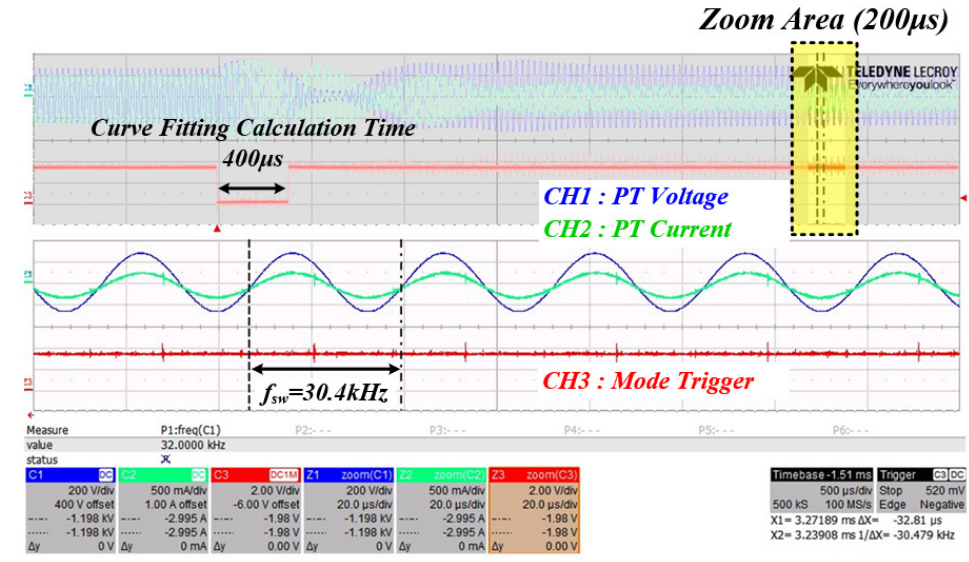
Figure 28. PT output waveform when in mode